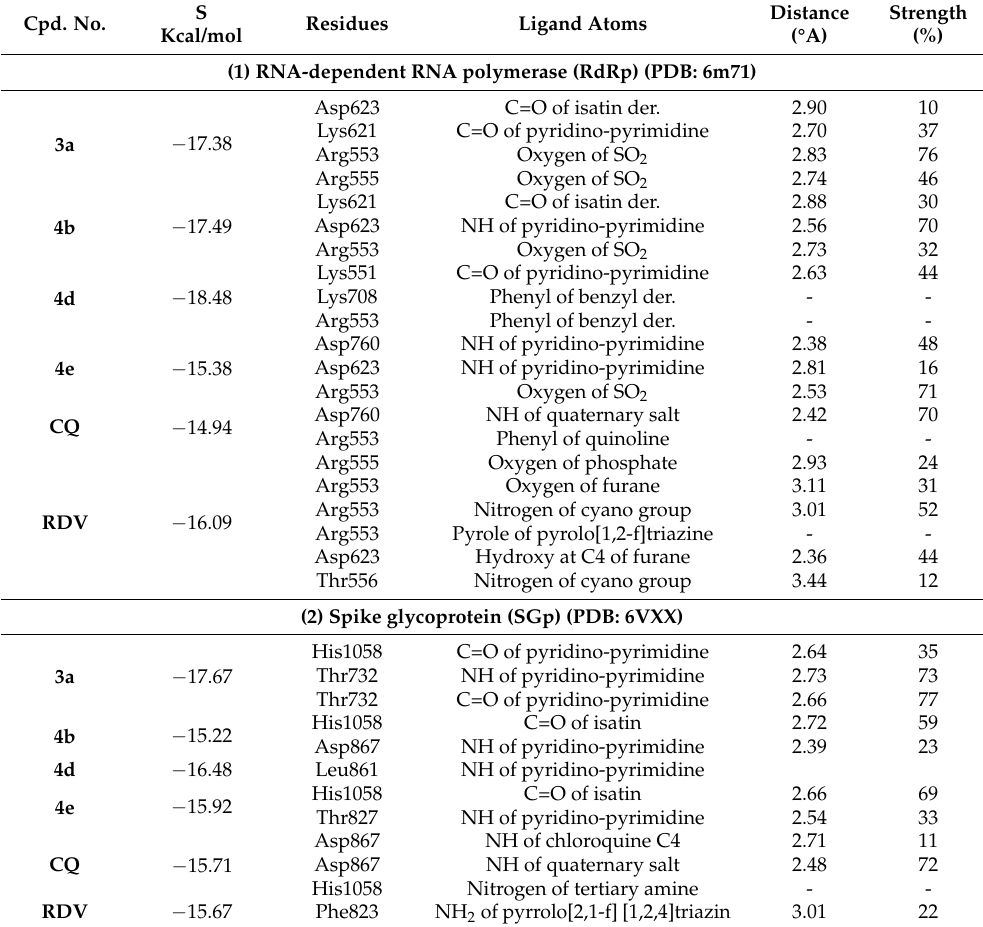
Table 4. The binding affinity (S) (kcal/mol) of the most promising derivatives, 3a , 4b , 4d , 4e , and positive controls ( Chloroquine and Remdesivir ) inside the active site of RNA polymerase (PDB: 6m71 ) and spike glycoprotein (PDB: 6VXX ). Cpd.